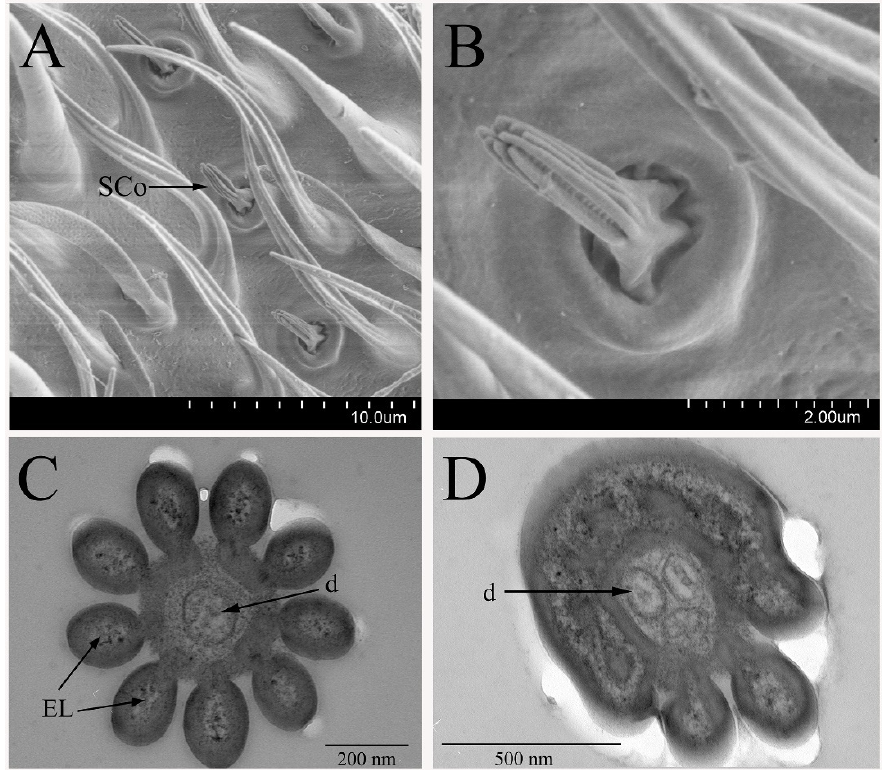
Figure 5. Sensilla coeloconica on the flagellum of B. dorsalis : ( A ) distribution of SCo on the funiculus. ( B ) SCo on a male adult antenna, showing the “finger-like” structures. ( C ) Cross-section of the distal region of the SCo shows the central lumen is surrounded by several petal-like extra-lumen (EL). One dendrite (d) is visibly accessible because the other neuron’s termination is covered by the visible plane. ( D ) Cross-section of SCo-3 on male antennae shows three dendrites appear in the sensillum lumen. The double-wall of the sensilla is visible, and electron dense tubules fill the space between the outer and inner walls.